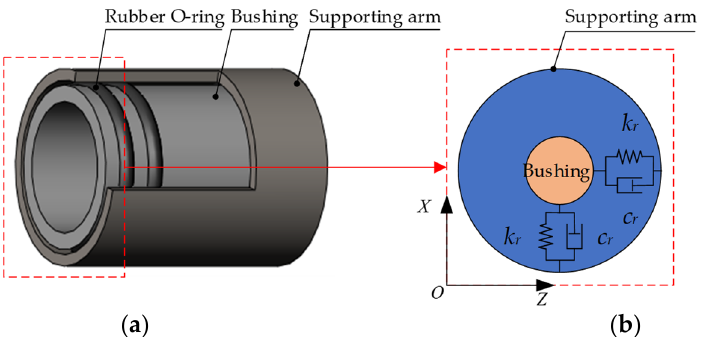
Figure 6. Supporting element of the rubber O-ring. ( a ) Flexible support; ( b ) equivalent linear spring-damping model.